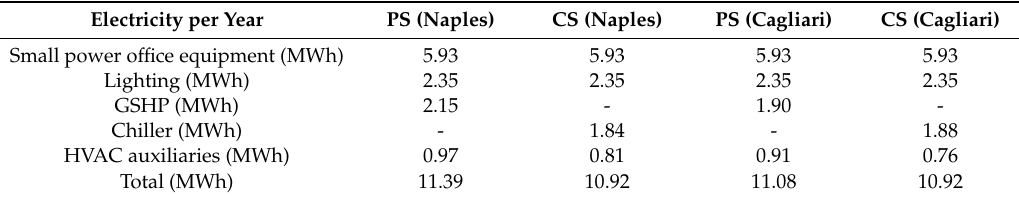
Table 5. Annual electricity demand of the end-user.